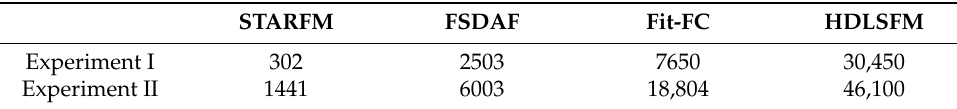
Table 6. Computation costs of different STF methods (in seconds).